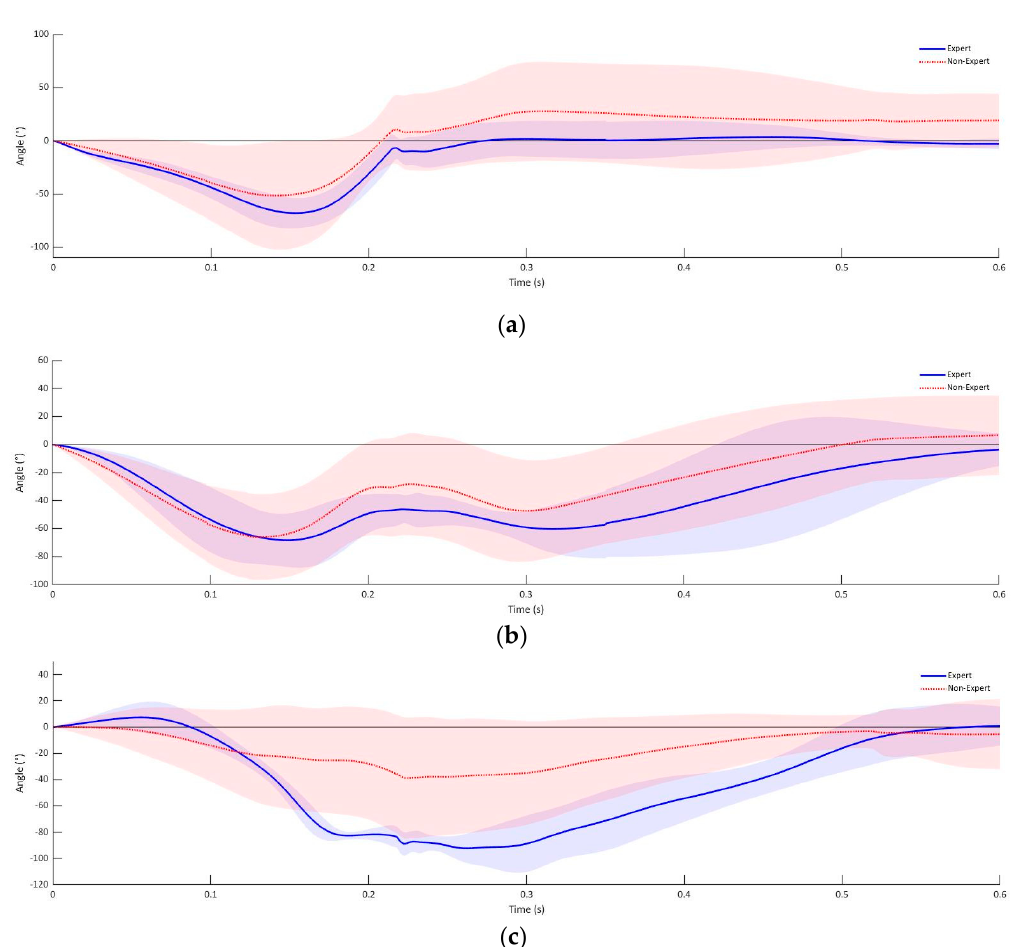
Figure 5. Fist rotation experienced athletes hook punch: ( a ) longitudinal, ( b ) transversal and ( c ) sagittal axis.